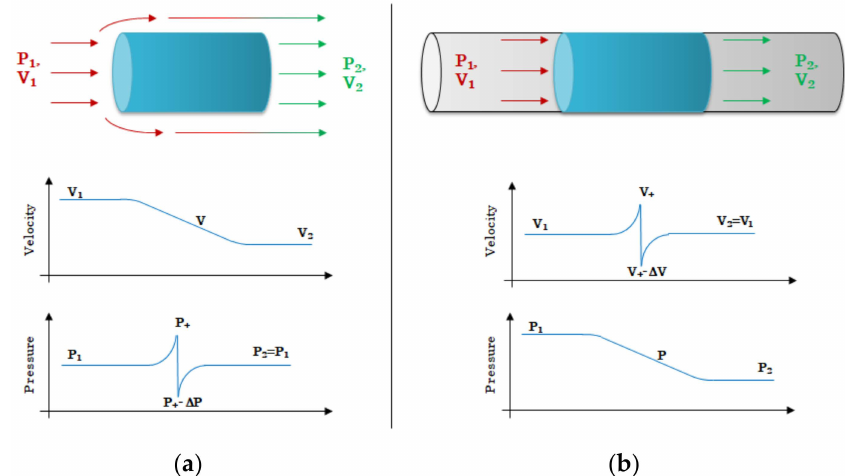
Figure 5. Open space operation principle versus test-bench operation principle. ( a ) Harvester in an open space. ( b ) Harvester in a